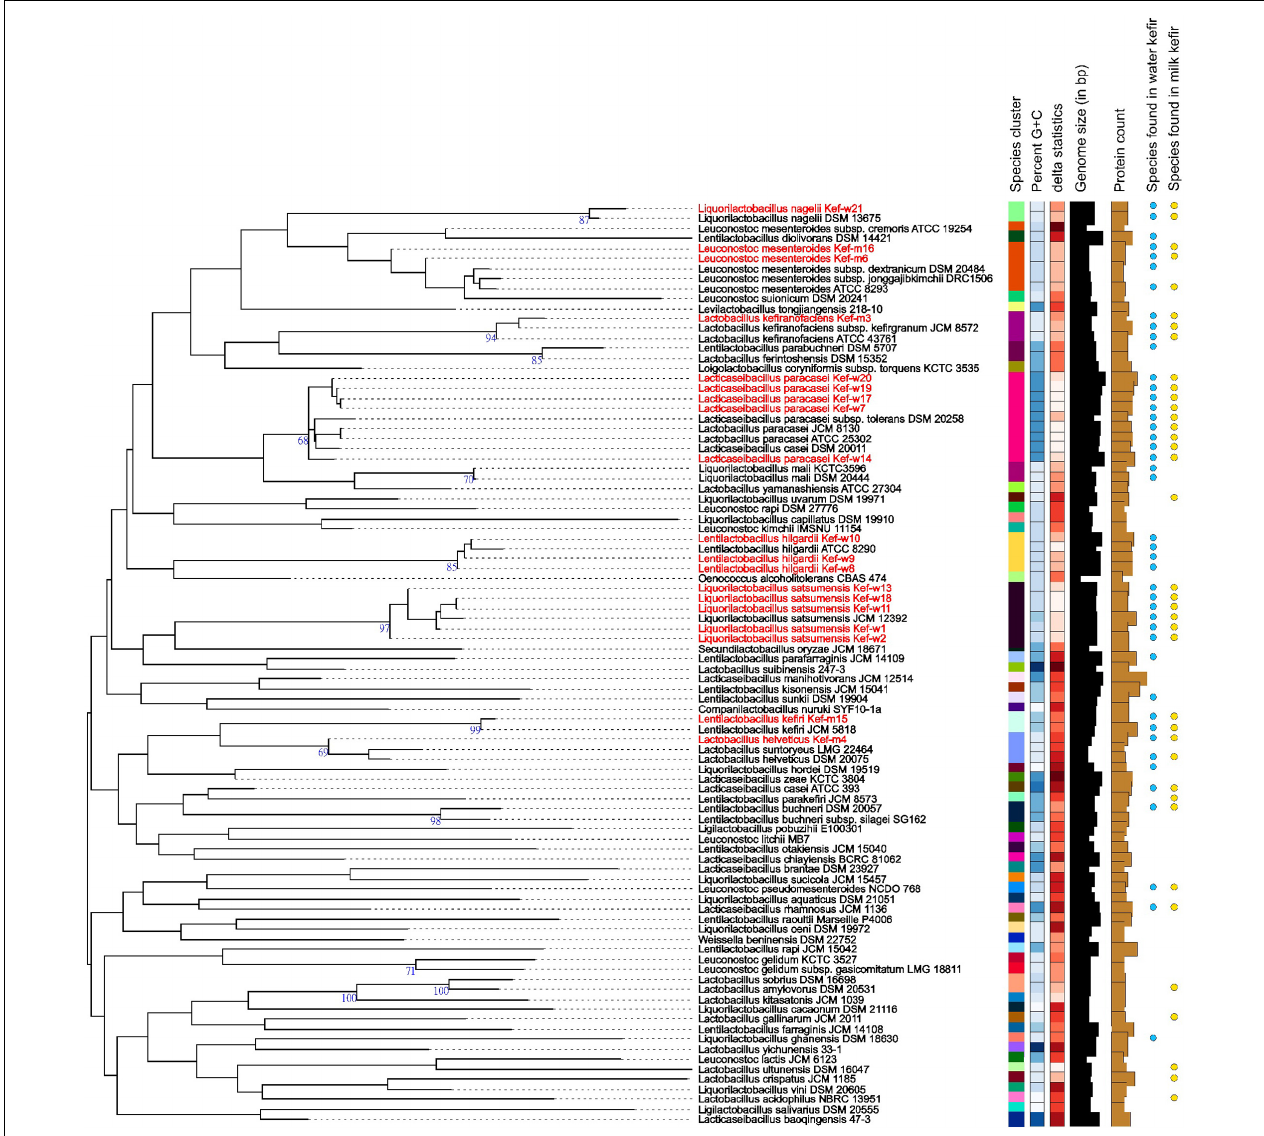
FIGURE 1 | Phylogenetic tree of selected kefir isolates (highlighted in red) and other related strains. The branch lengths are scaled in terms of Genome BLAST Distance Phylogeny approach (GBDP) distance formula d 5